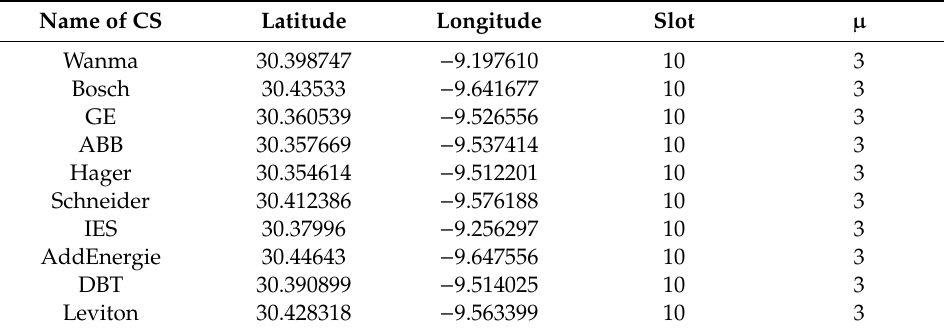
Figure 5. Simulation Scenario of Agadir City. Table 2. Parameters of electric vehicle public supply station (EVPSS).